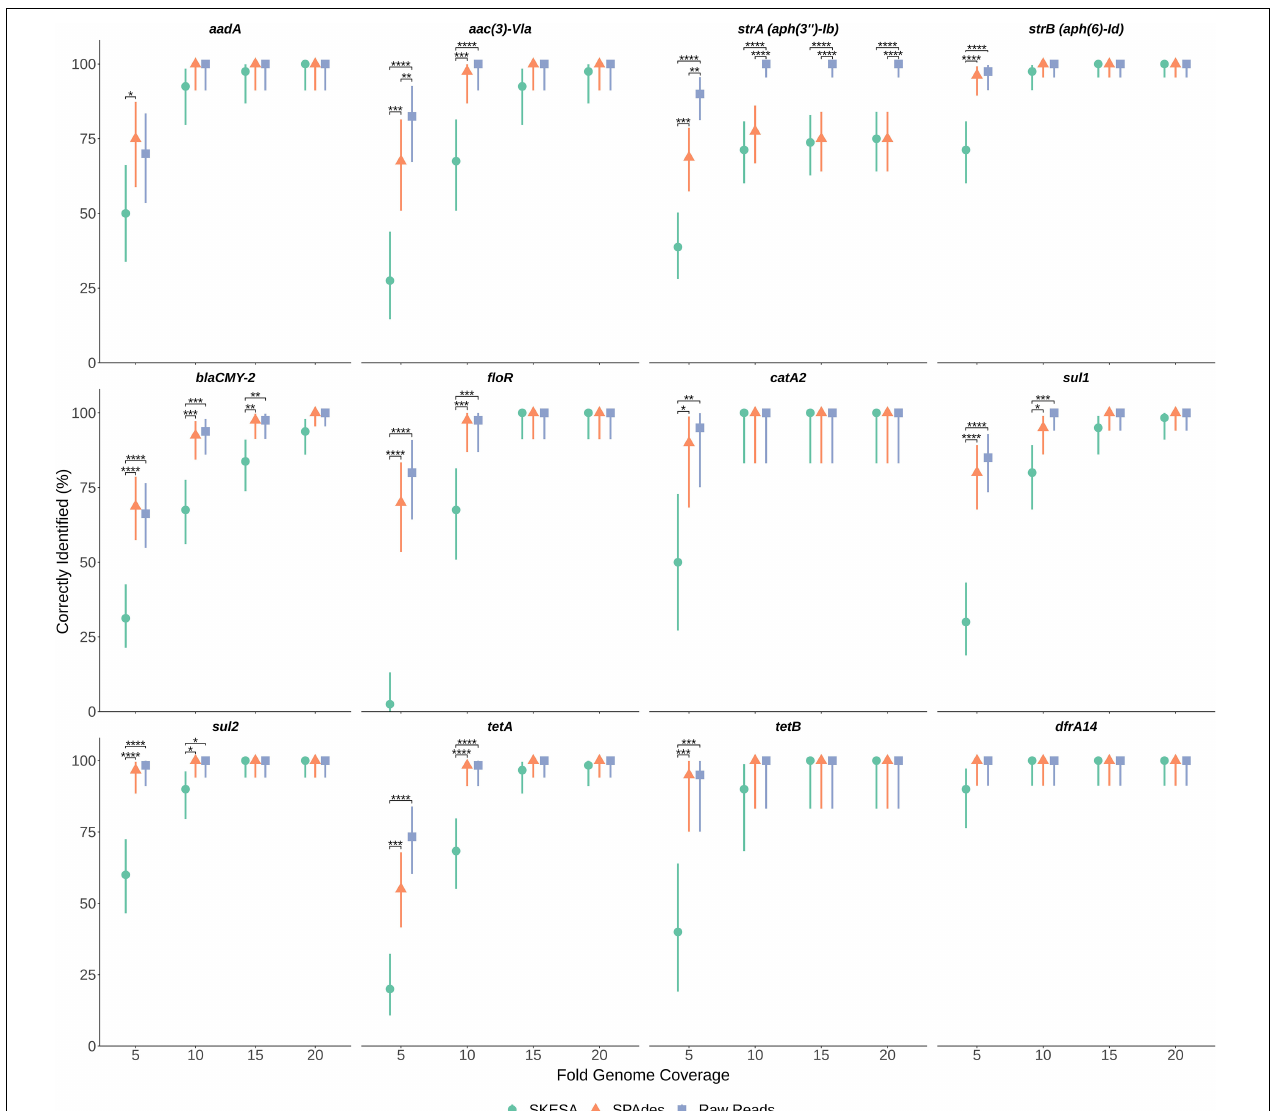
FIGURE 2 | Effects of sequence coverage and assembly on ARG detection. Levels of 5X, 10X, 15X and 20X genome coverage were subsampled 20 times from raw-reads of sequence files for seven Salmonella isolates and assembled using both SPAdes and SKESA. Panels are separated by gene (listed at top of each panel). Proportion gene was identified out of n trials ( n = 20, 40, 60, or 80 depending on gene) is plotted on y -axis with upper and lower 95% confidence intervals. Significance of proportion detected between assemblies and raw-reads was determined for each gene at each coverage level using Fisher’s exact test. Significance values are displayed above corresponding data points: p < 0.05 = *; p < 0.01 = **; p < 0.001 = ***; p < 0.0001 = ****